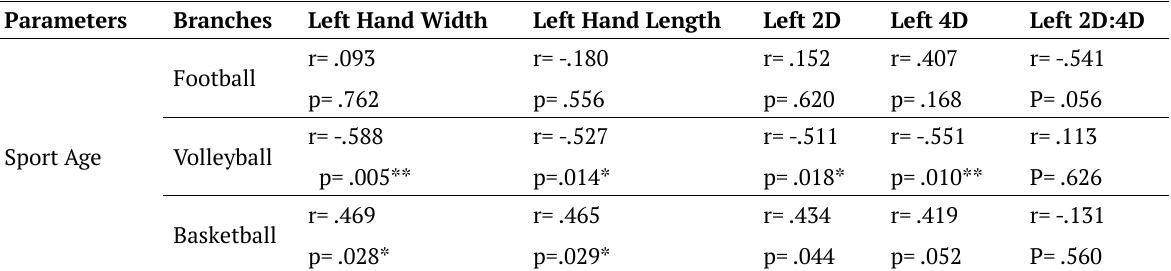
Table 5. The Relationship Between Sports Age and Left Hand Parameters Parameters